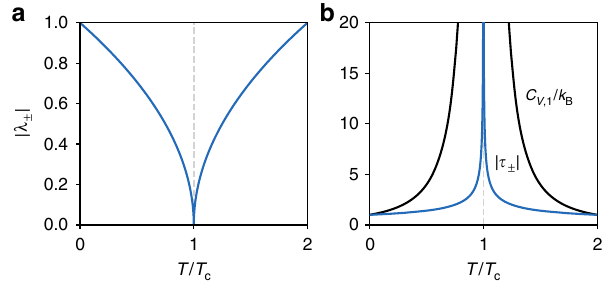
Fig. 2 Analytical model of nonlinear oscillators with a dynamically stable critical point. At the critical temperature T c , a the N conjugate pairs of Lyapunov exponents, | λ ± |, vanish and b the single-particle heat capacity, C k V ,1 / B , and Lyapunov time, |